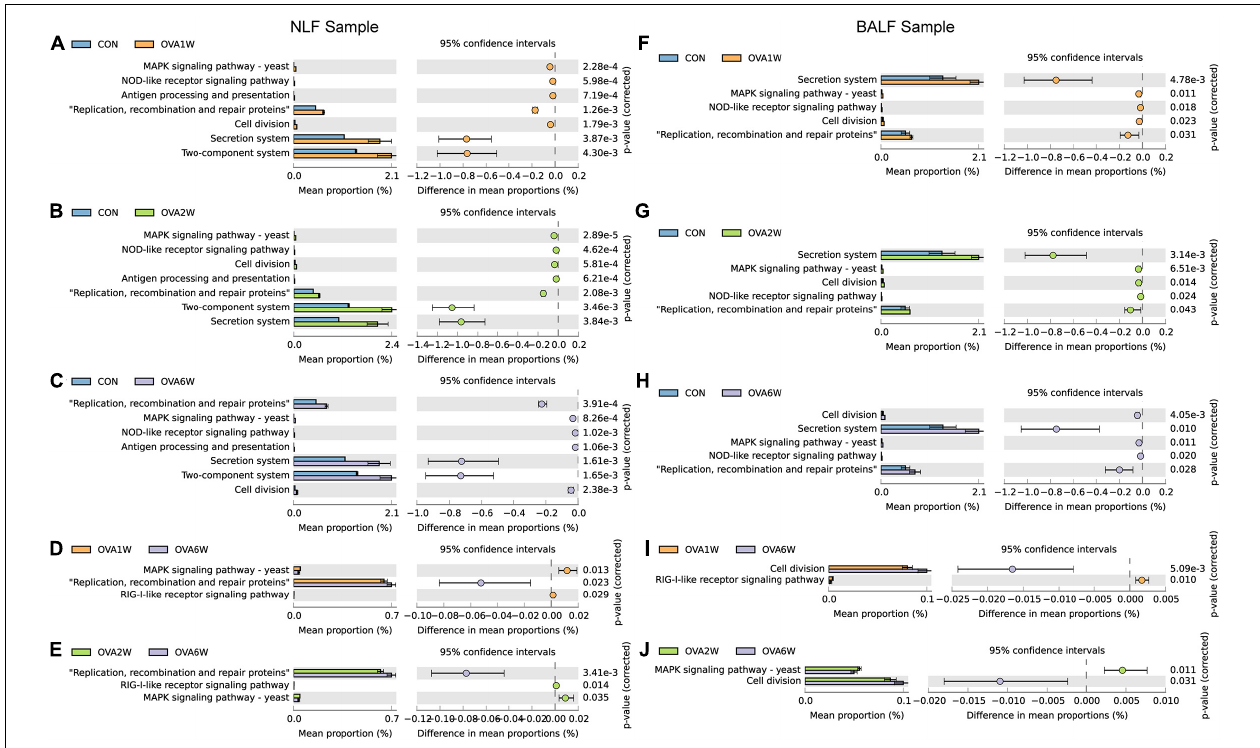
FIGURE 6 | Metagenomic functional prediction of the respiratory microbiota using PICRUSt. Bacterial metagenomic functional categories were derived from level 3 KEGG pathways. Gene functions with a significant difference (corrected P value < 0.05) and parts of the pathways associated with asthma are shown. (A) Control group vs OVA1W group in URT samples. (B) Control group vs OVA2W group in URT samples. (C) Control group vs OVA6W group in URT samples. (D) OVA1W group vs OVA6W group in URT samples. (E) OVA2W group vs OVA6W group in URT samples. (F) Control group vs OVA1W group in LRT samples. (G) Control group vs OVA2W group in LRT samples. (H) Control group vs OVA6W group in LRT samples. (I) OVA1W group vs OVA6W group in LRT samples. (J) OVA2W group vs OVA6W group in LRT